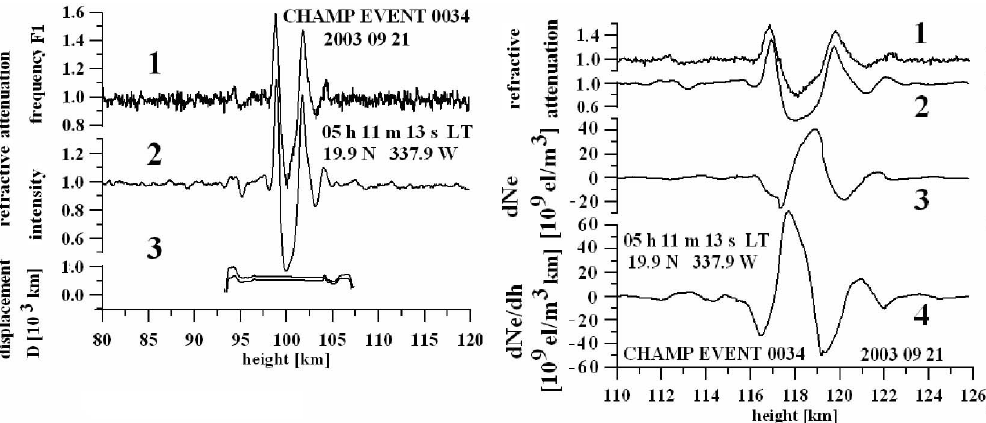
Fig. 8. Comparison of the refractive attenuation recalculated from the excess phase path data X p , and refraction attenuation X a found from the amplitude data at the first GPS frequency f 1 (curves 1 and 2), results of estimation of distance d from the RO ray perigee (curve 3) (left panel) and retrieved variations of the electron density and its gradients (curves 3 and 4) (right panel).